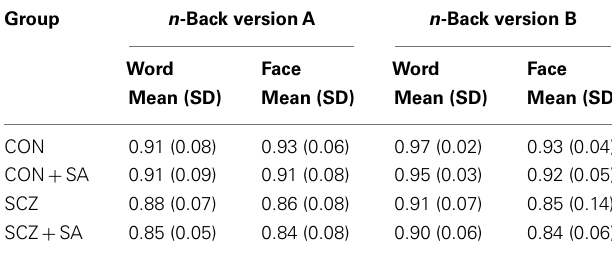
Table 3 |Accuracy during the working memory tasks